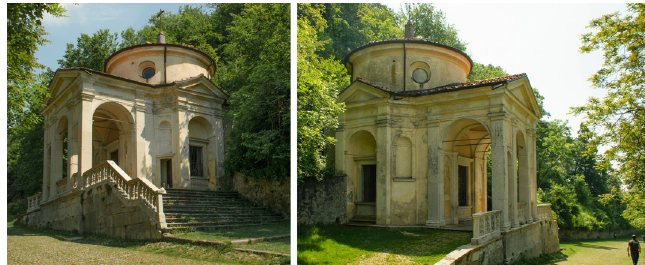
Fig. 5 Chapel VIII, photographs of the relationship with the